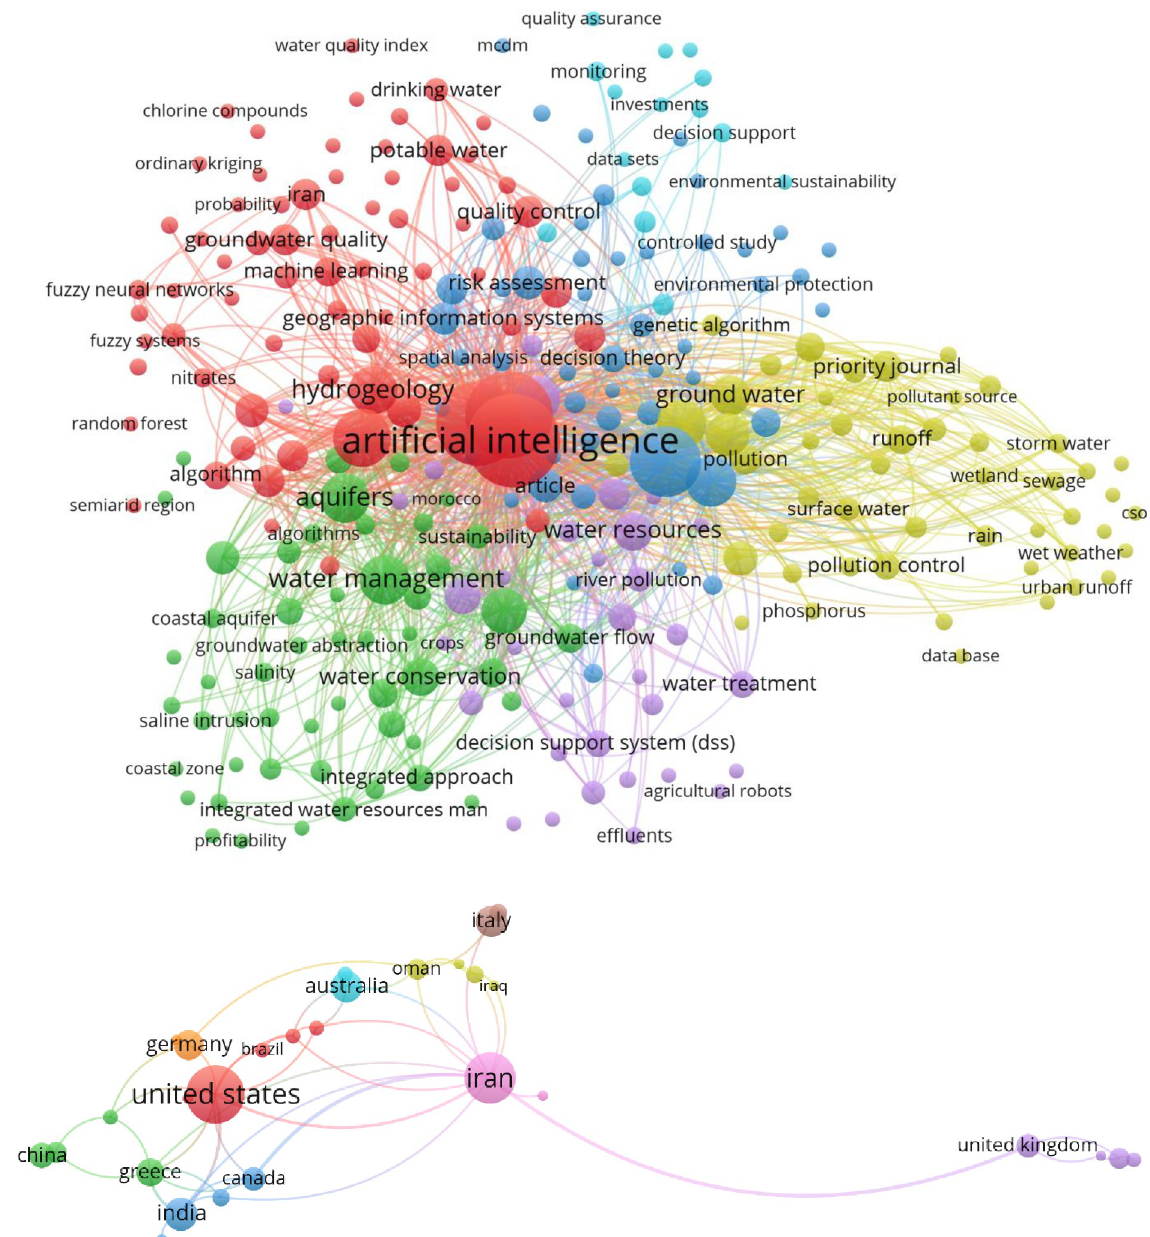
Fig 1. The literature review analysis for the groundwater quality simulation using the capacity of the AI models over the past two decades and the counties who conducted research on this research